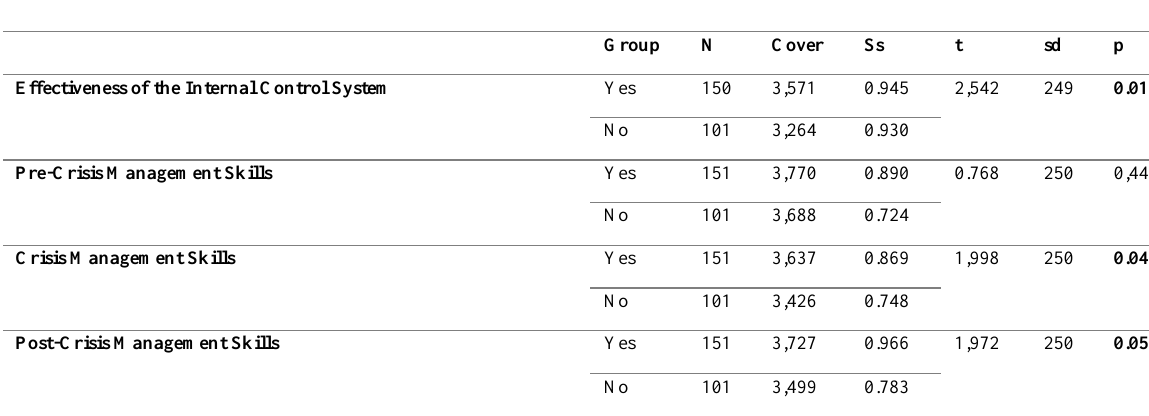
Table 13: T-Test Differentiation Status of Participants' Effectiveness of ICS and Crisis Management Skills Scores According to their Training in Disaster Psychology / Awareness / Management